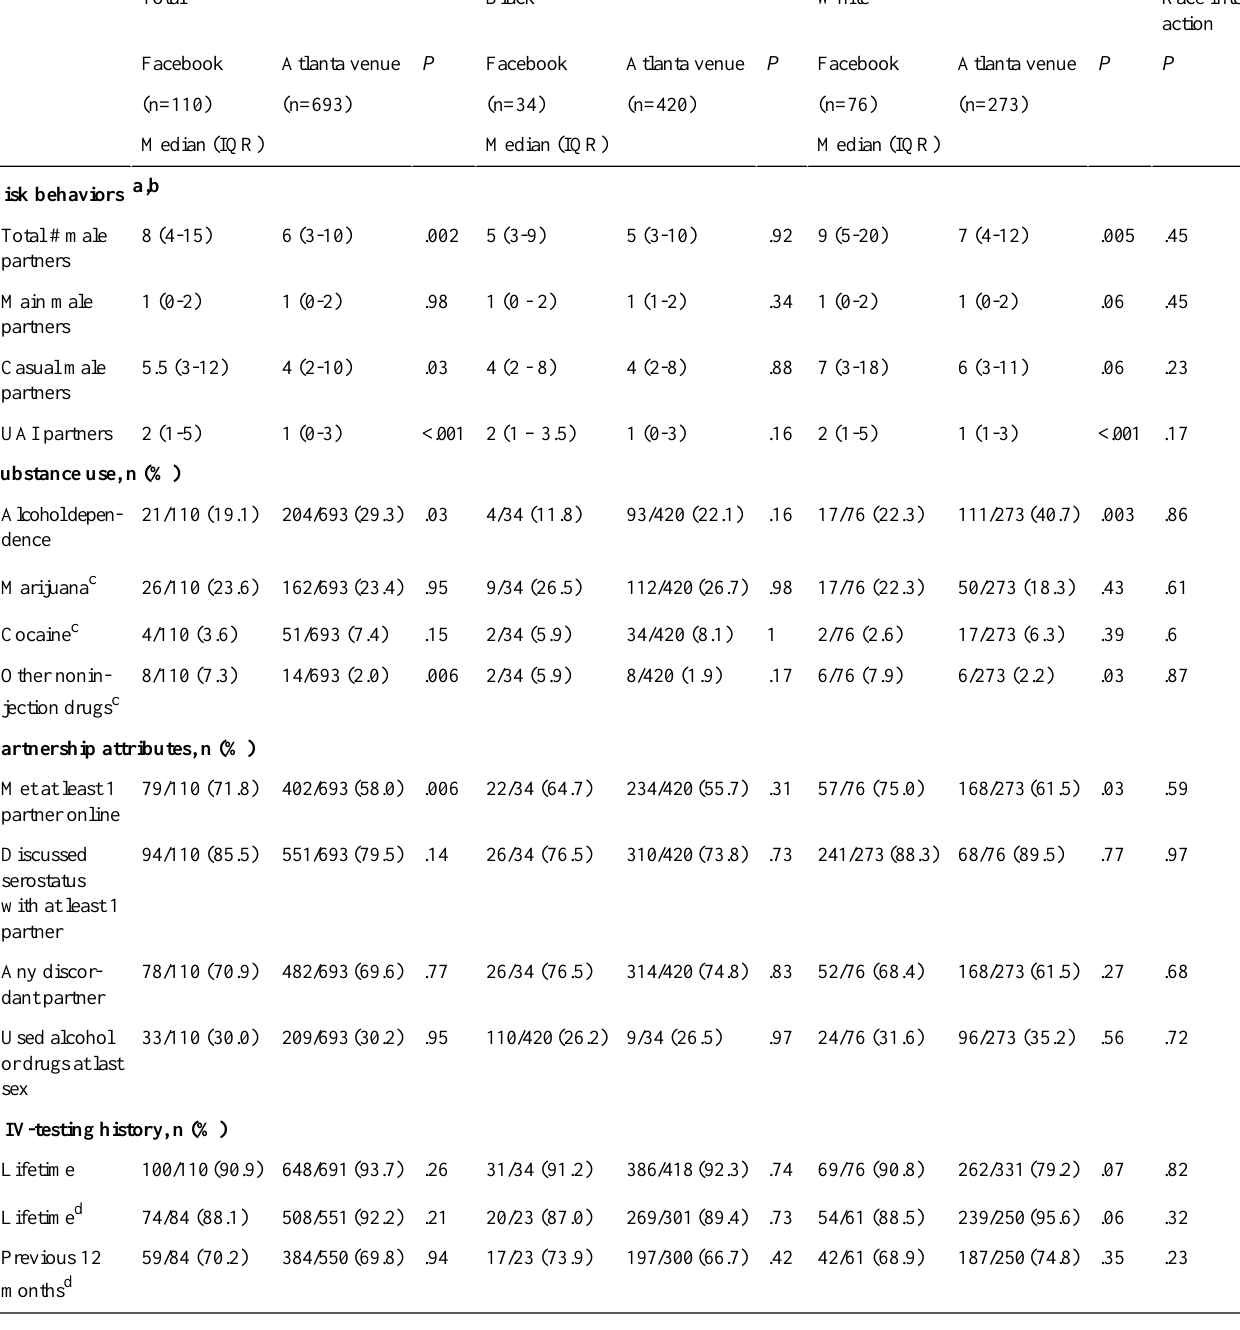
Table 3. HIV risk and prevention behaviors by recruitment type (Facebook vs Atlanta Venues) and race, InvolveMENt, Atlanta, GA.